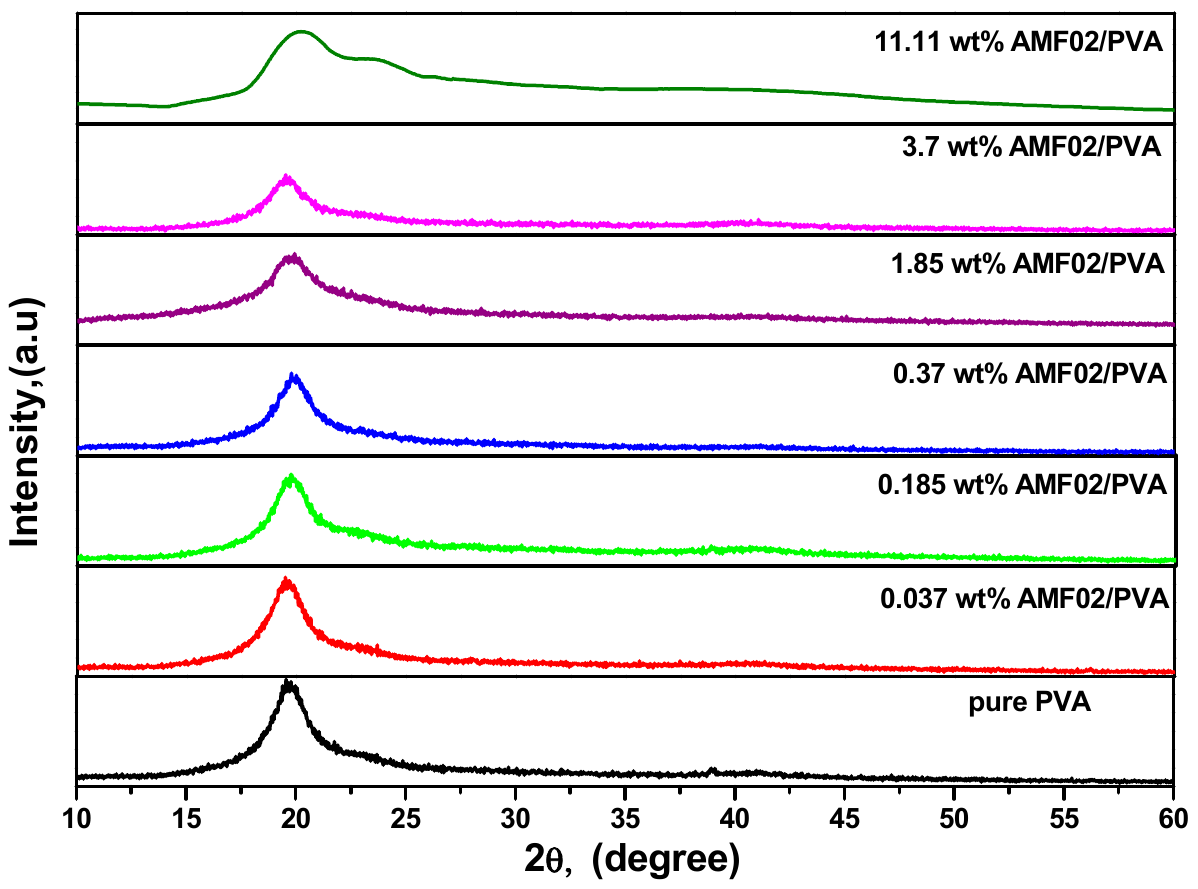
Figure 1. X-ray diffraction (XRD) shapes for pure polyvinyl alcohol (PVA) and different wt% of AMF02 salt-filled PVA novel proton-conducting composite electrolyte films (PCCEFs).